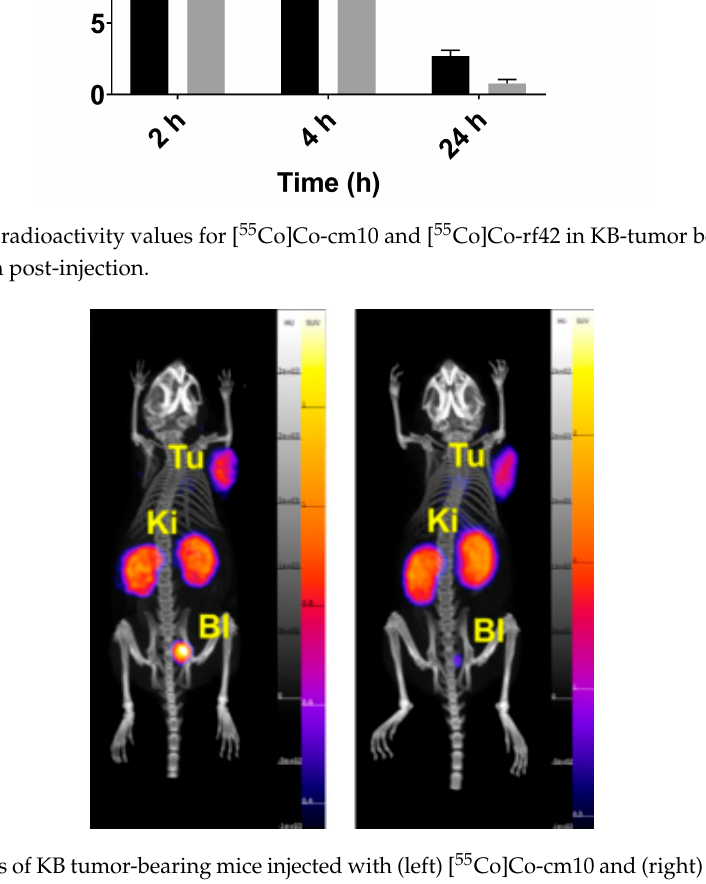
Figure 5. Images of KB tumor-bearing mice injected with (left) [ 55 Co]Co-cm10 and (right) [ 55 Co]Co- rf42 at 4 h post-injection. Shown as maximal intensity projections. (Tu = tumor, Ki = kidney, Bl = bladder).